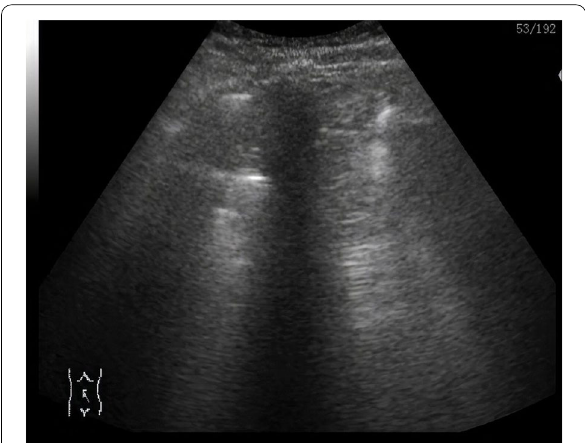
Fig. 2 The second patient is 43-year-old male patient complaining of fever for 3 days associated with cough, symptoms of pharyngitis and dyspnea. He is a moderate smoker. He was telling a history of close contact with Covid-19 infected patient. He was examined in ER, and was hemodynamically stable but with high temperature (38.9° C) and with O2 saturation of 91%. Chest X ray revealed bilateral reticulo-nodular infiltrates in both middle and lower lung lobes. Lung ULS showed areas of consolidation and thick smooth pleural line. B-lines were few and dispersed and there was no pleural effusion. He has low score of suspicion and proved to be non-Covid after 3 PCR swabs